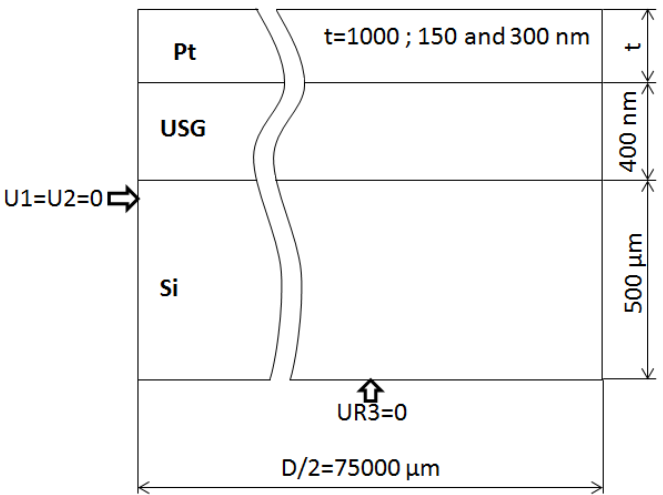
Coatings 2023 , 13 , x FOR PEER REVIEW Figure 2. Geometry and boundary conditions of the 2D axisymmetric model. Figure 2. Geometry and boundary conditions of the 2D axisymmetric model.